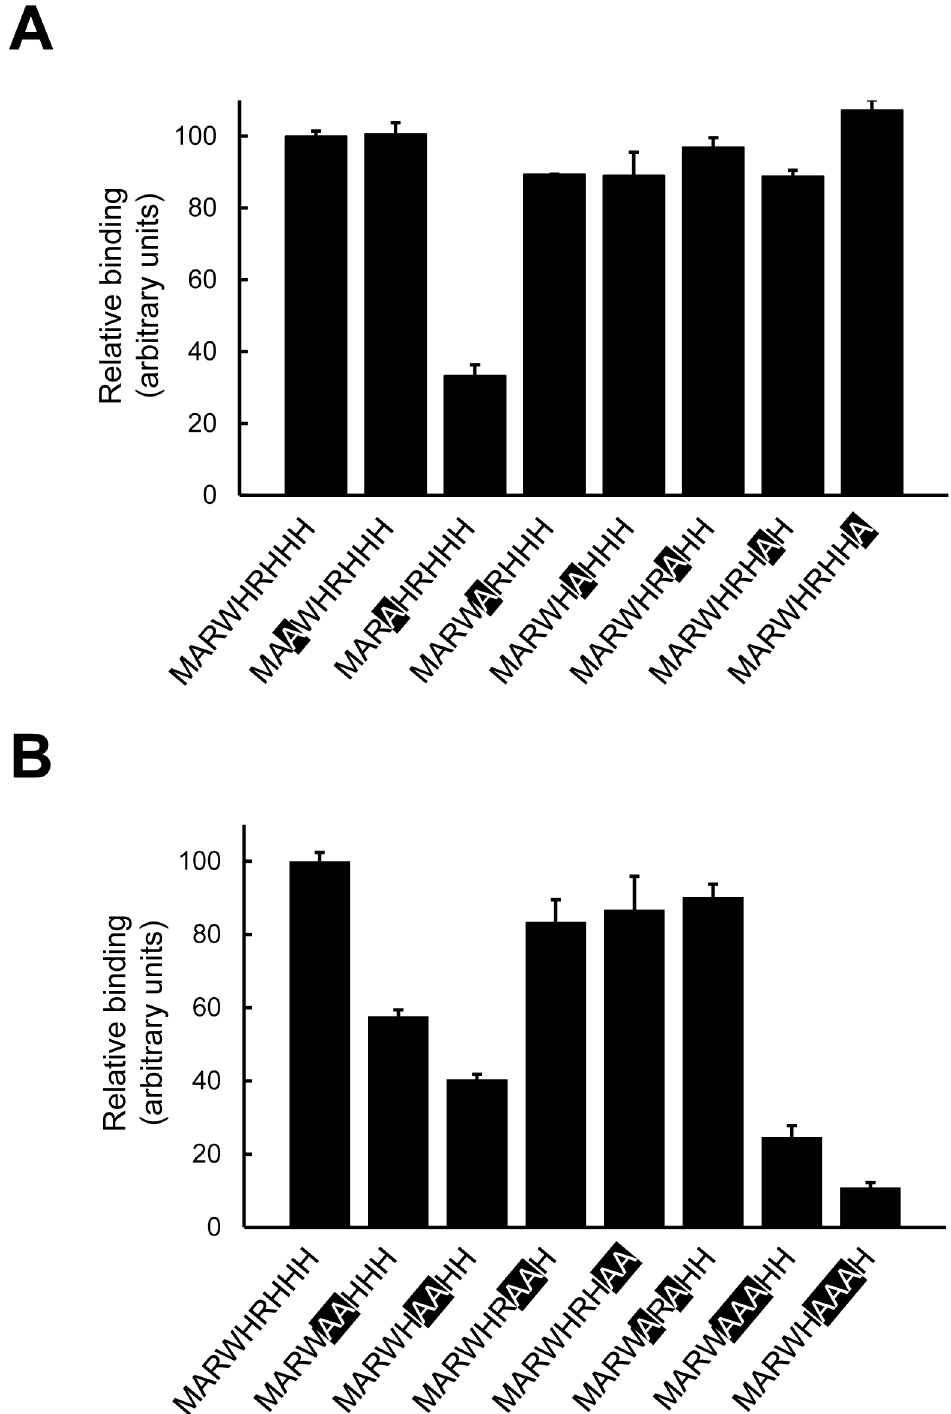
Fig 5. Identification of amino acid residues involved in the PA-binding. (A, B) Binding of alanine mutants of PAB-TP to LUVs (125 μ M total lipids) composed of DOPA/DOPC/biotin-DOPE/cholesterol (10:58:2:30) was examined by the SPVB assay. Substituted amino acids were indicated by outline characters. (mean ± SE, n = 3). The binding of LUVs to PAB-TP (MARWHRHHH) was represented as 100 (arbitrary